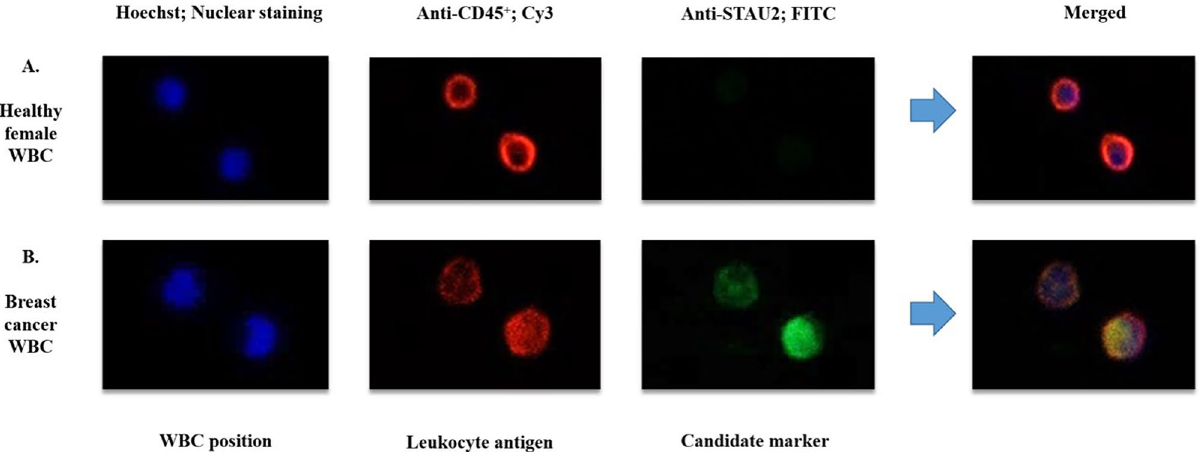
Figure 1. Immunofluorescence signal from WBCs from ( A ) breast cancer patients and ( B ) healthy females observed by confocal microscopy (20×). Hoechst was applied to locate WBC position. Anti-CD45 + was used as a positive control for WBCs. The merged group refers to the combination of 3 fluorescent signals. The positive fluorescent signal from anti-STAU2 was exclusively observed in breast cancer WBCs.